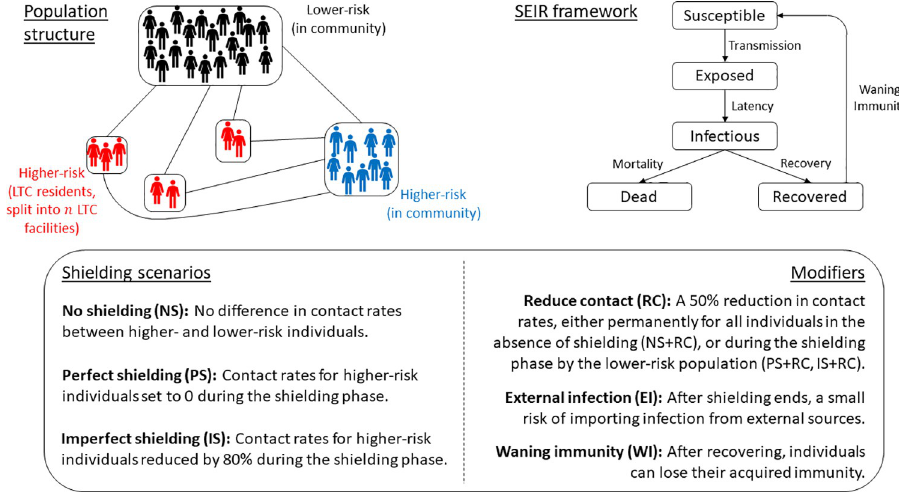
Fig 1. Schematic for the model. Top left: Population structure, with lines indicating contacts between subpopulations, each of which are well-mixed. Top right: Transitions through the different infection states in the SEIR model. Bottom: Description of the shielding scenarios and modifying